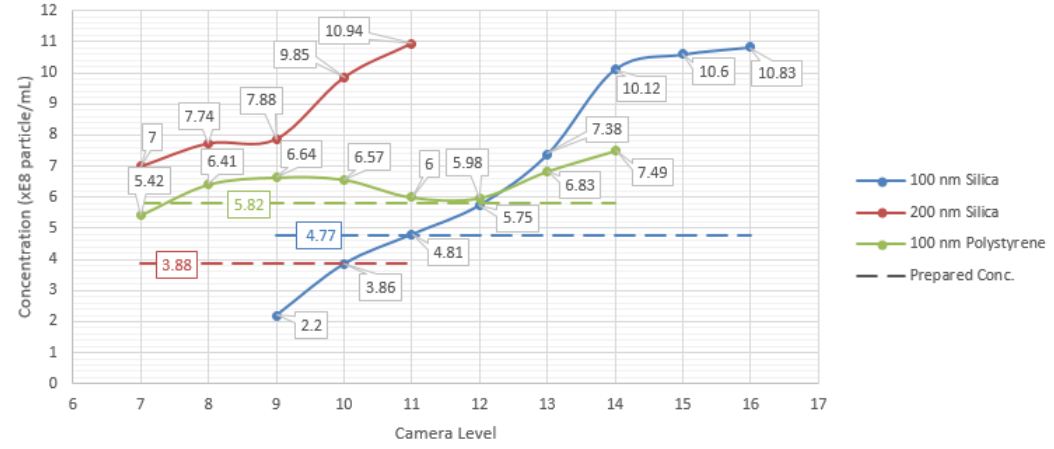
Figure 7. Effect of changing the camera levels on the measured concentration for 100 nm silica, 200 nm silica and 100 nm polystyrene samples. Prepared concentration values for each of the samples are shown as dotted lines. The last point in each sample line corresponds to the recommended camera level by the software for the measured